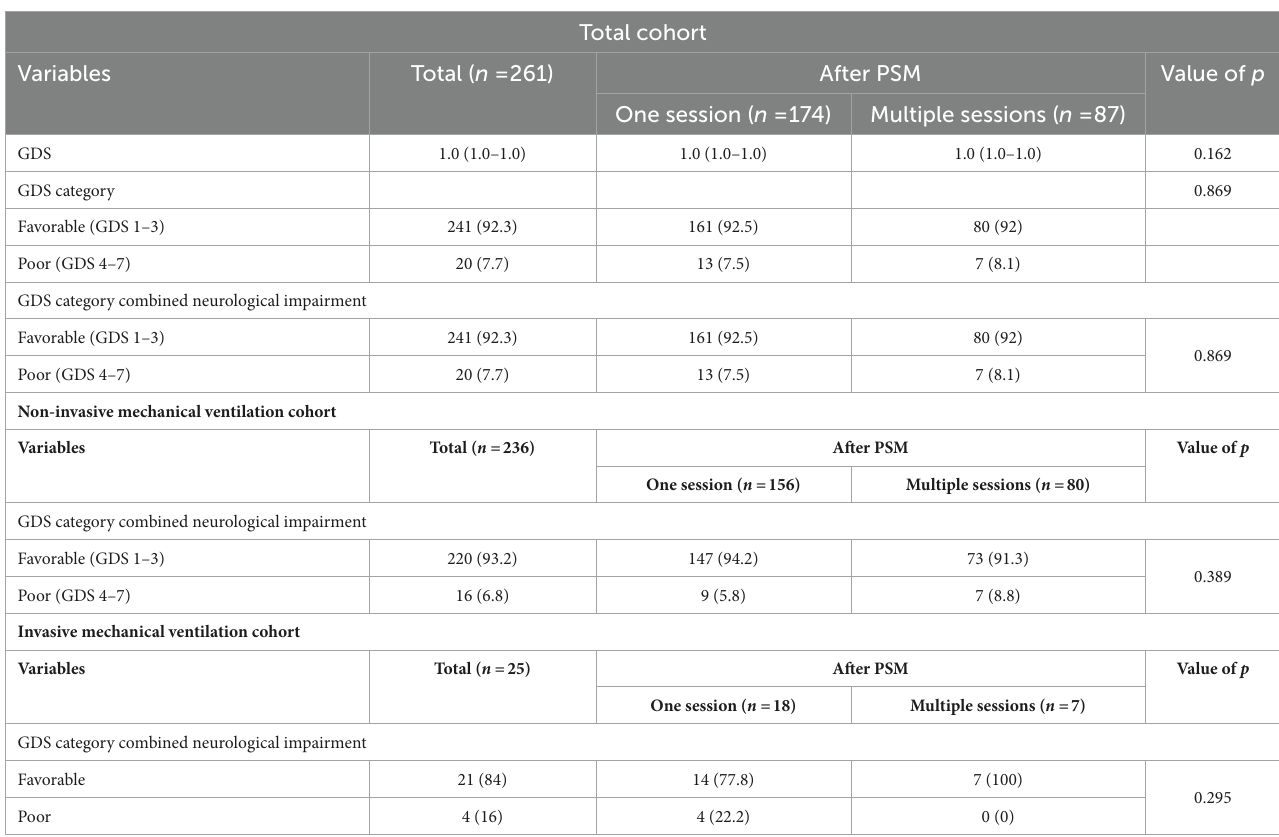
TABLE 2 Neurocognitive